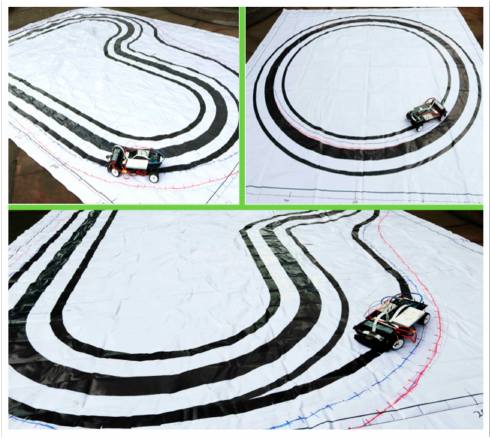
Figure 13. Outdoor field test